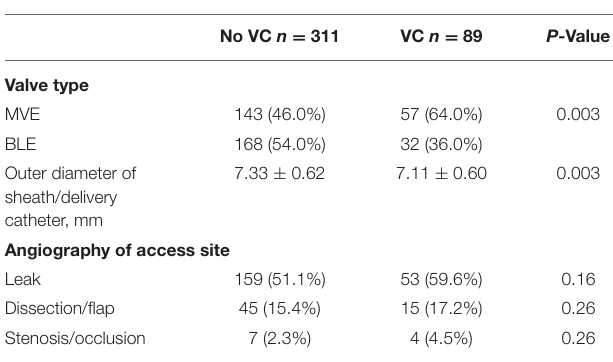
TABLE 3 | Procedural